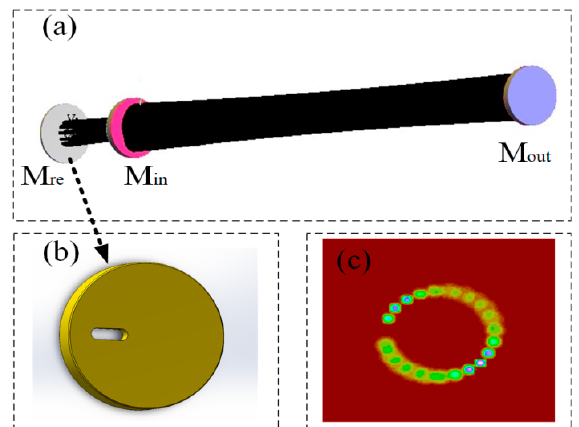
Figure 3. Reinjection structural parameter simulation: ( a ) light simulation of integral reinjection off-axis device; ( b ) reinjection mirror; ( c ) reflectional arrangement of light spots on the surface of the reinjection mirror.